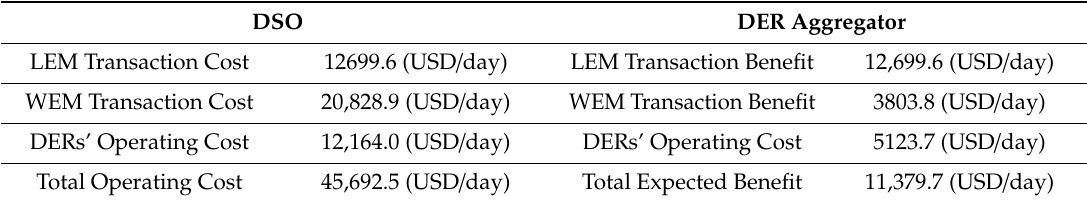
Table 10. Cost and benefit distribution of market participants without considering the competitive environment.